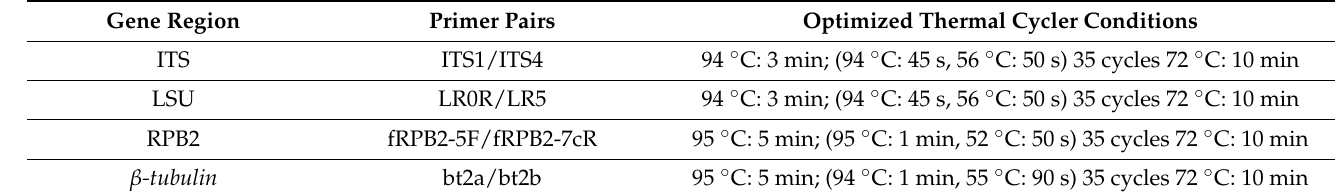
Table 1. Gene regions, respective primer pairs, and thermal cycler conditions used in this study. Gene Region Primer Pairs Optimized Thermal Cycler Conditions